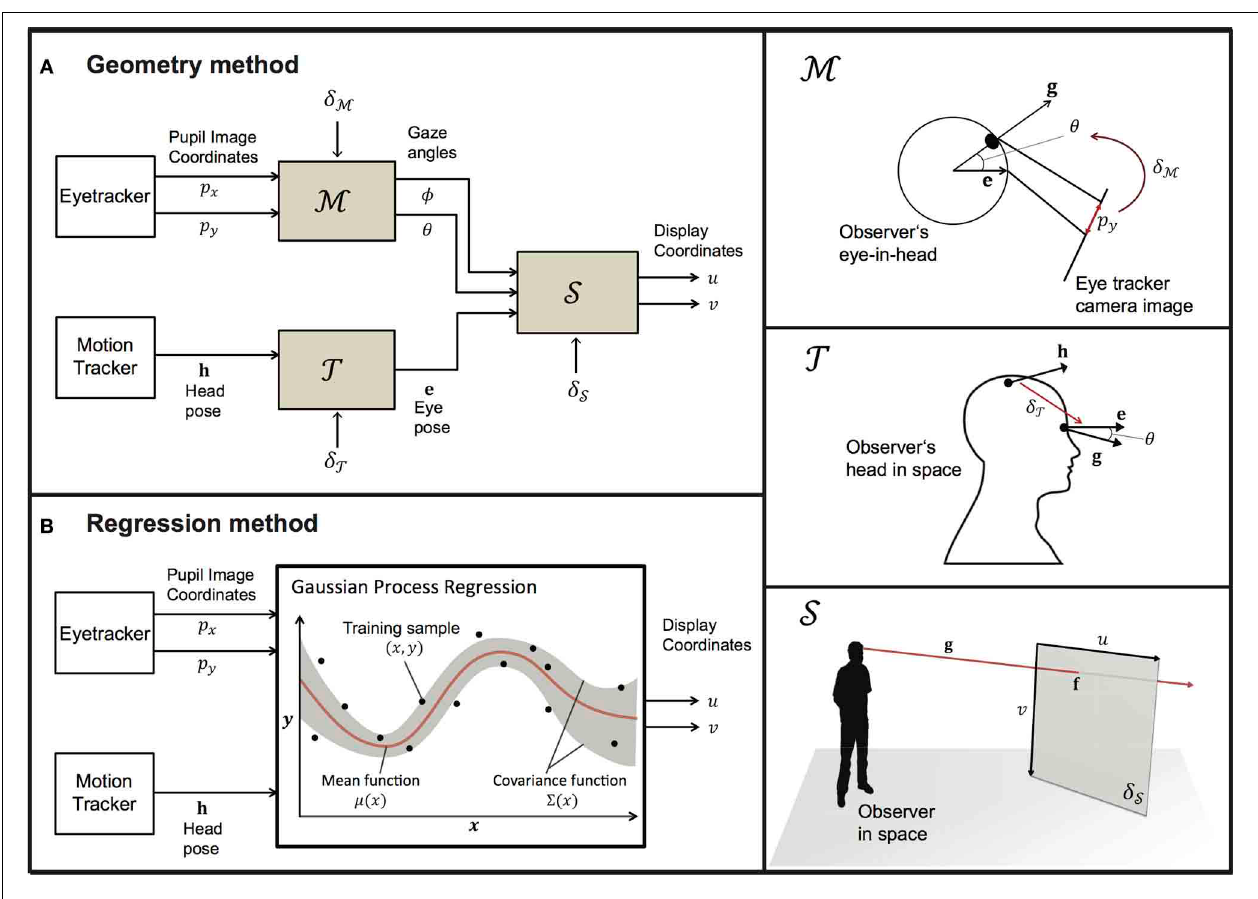
FIGURE 1 | A flowchart representation of the geometric (left panel; A) and regression (left panel; B) approach. Both approaches map data from the eye- and motion-tracking systems